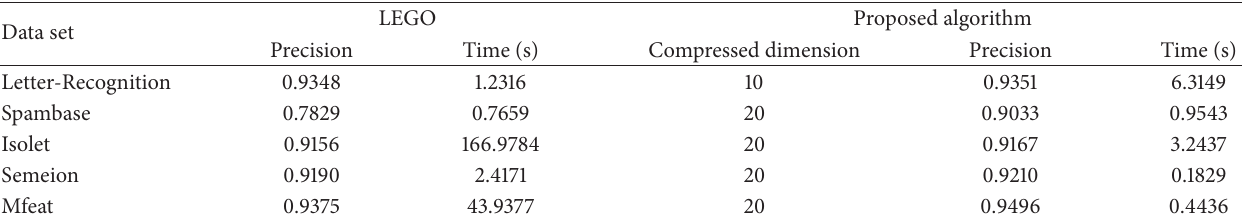
Table 4: Performance comparison with the state-of-the-art online metric learning methods on the large data